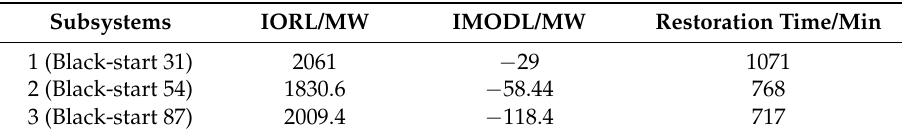
Table 5. The sectionalizing result in Scenario